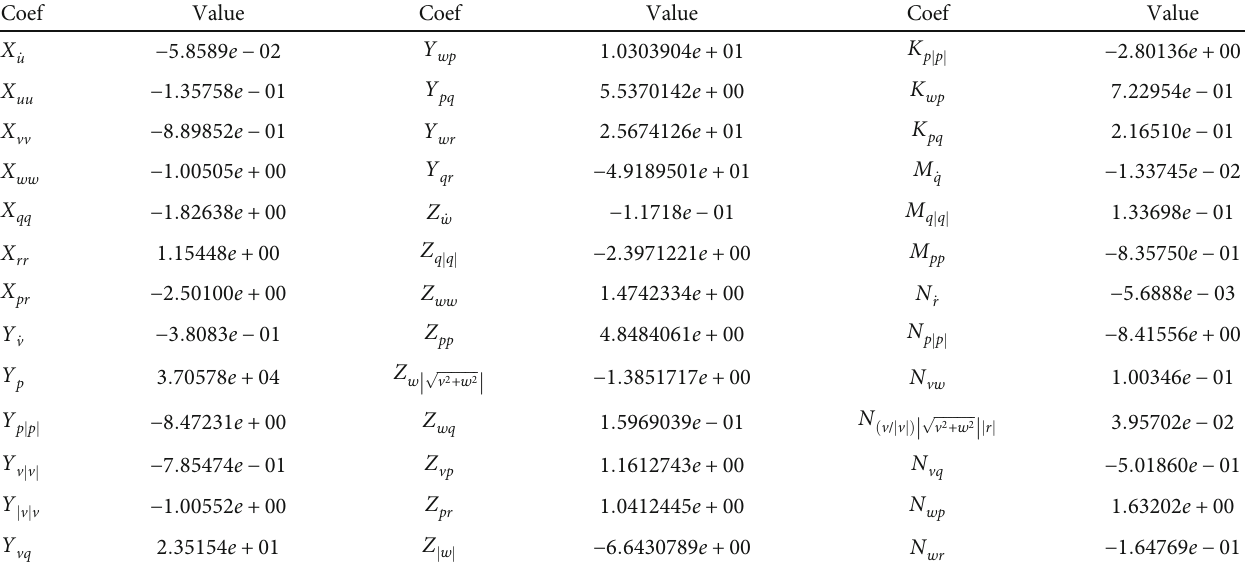
Table 4: Simpli fi ed hydrodynamic coe ffi